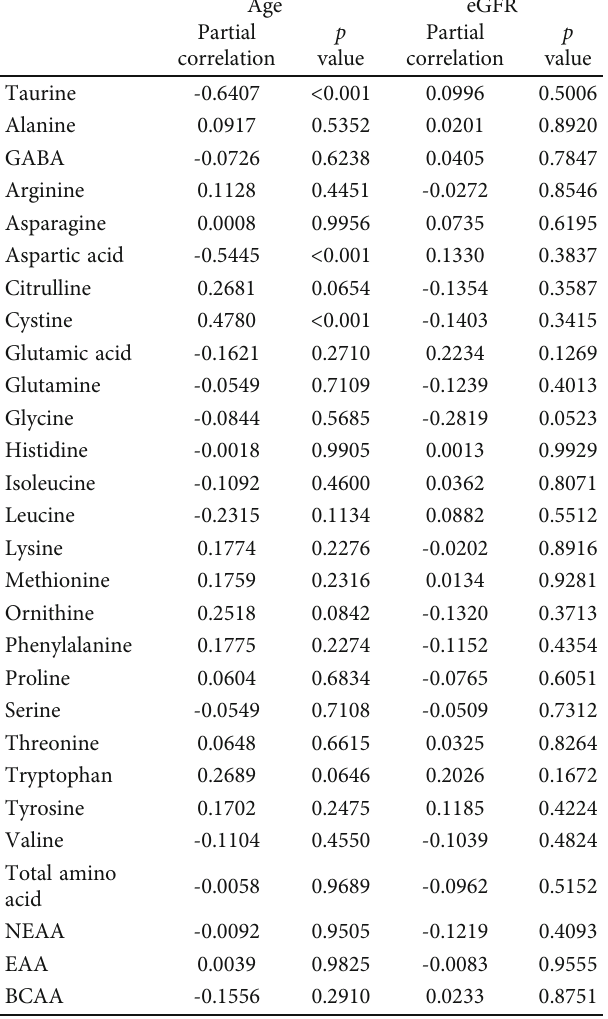
Table 1: Correlation among each amino acid according to age and eGFR in control participants.